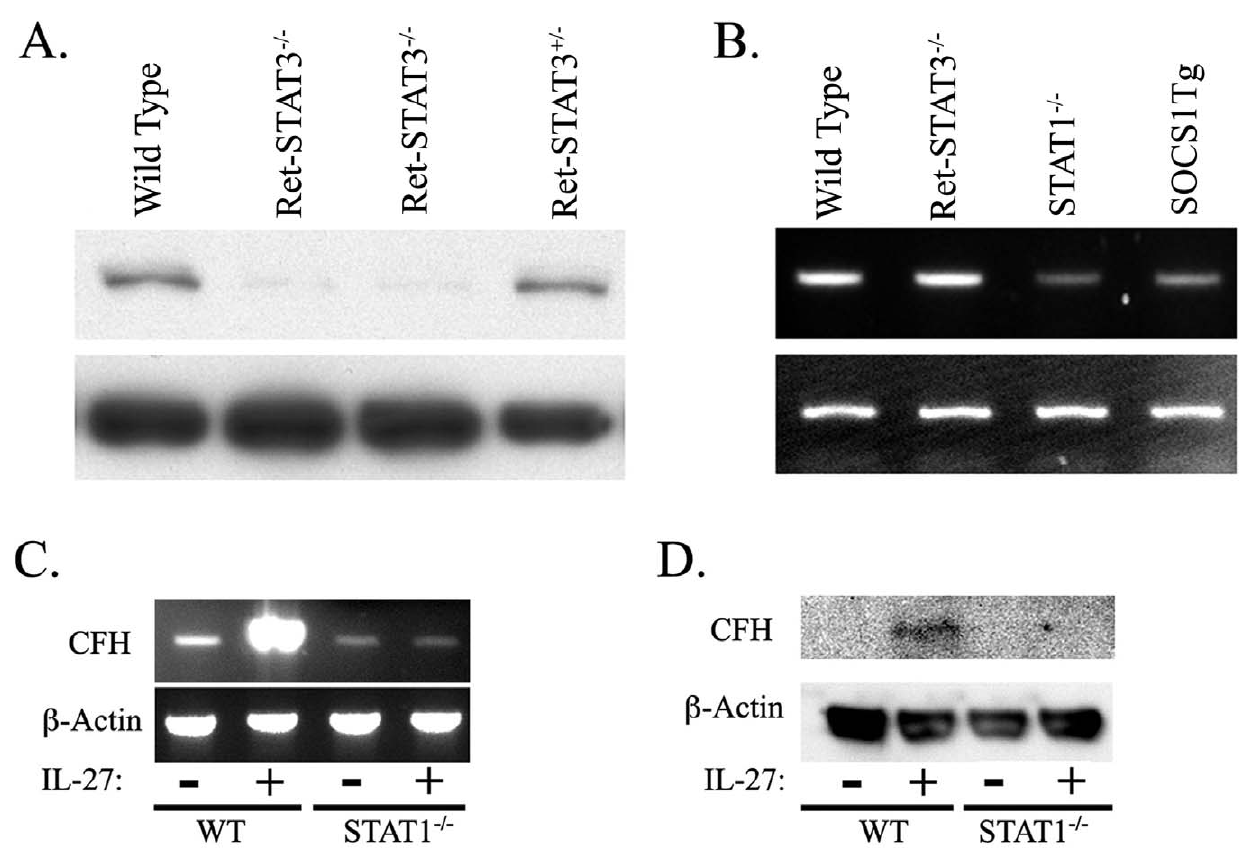
Figure 2. IL-27 induces CFH expression in the retina through STAT1-dependent mechanism. (A) Characterization of retina from mice with specific deletion of STAT3 in the retina (Ret-STAT3 2 / 2 ). (B) Freshly isolated retinas from wild type (WT), STAT1 knockout (STAT1 2 / 2 ), (Ret-STAT3 2 / 2 ), or from mice with targeted over-expression of SOCS1 in the retina (SOCS1Tg) were analyzed by RT-PCR. (C, D) Freshly isolated retinal cells from WT or STAT1 2 / 2 mice were cultured overnight, washed, starved for 2 hours in serum-free medium and then cultured for an additional 22 hours in medium containing IL-27 (10 ng/ml). We analyzed RNA and total cell extracts from the cells by RT-PCR (C) or Western blotting (D).